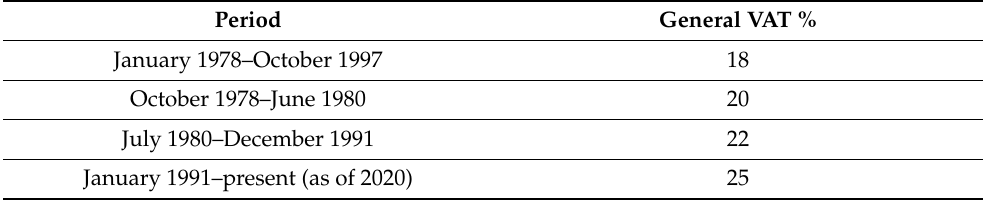
Table 4. VAT of Denmark, 1978 to 2020.